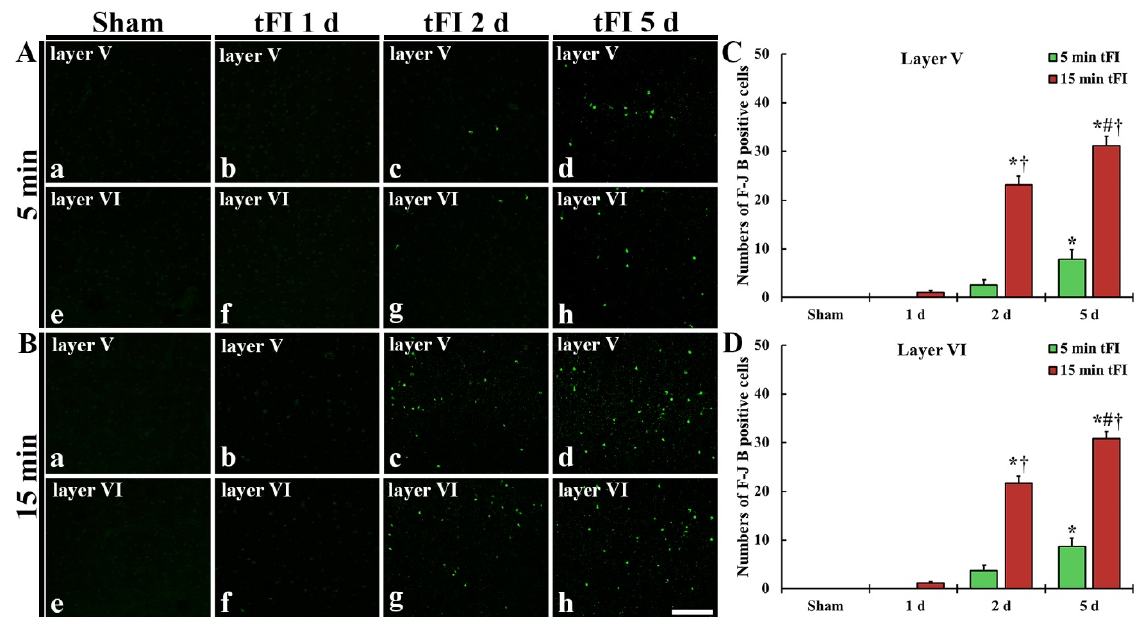
Figure 3. ( A , B ) F-J B histofluorescence staining in layers V and VI of the motor cortex in the mild sham ( Aa , Ae ), mild tFI ( Ab – Ad , Af – Ah ), severe sham ( Ba , Be ), and severe tFI ( Bb – Bd , Bf – Bh ) groups at one day ( Ab , Af , Bb , Bf ), two days ( Ac , Ag , Bc , Bg ) and five days ( Ad , Ah , Bd , Bh ) after tFI. A few F-J B-cells are detected in the mild tFI group two and five days after tFI. In contrast, many F-J B-cells are found in the severe tFI group two and five days after tFI. Scale bars = 200 μ m. ( C , D ) Numbers of F-J B-cells in layers V and VI, respectively ( n = 7, respectively; * p < 0.05, significantly different from mild and severe sham group, # p < 0.05, significantly different from pre-time point group and † p < 0.05, significantly different from mild tFI group at corresponding time point). The bars indicate the means ± SEM.